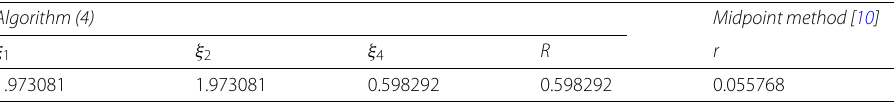
Table 6 Parameters for example